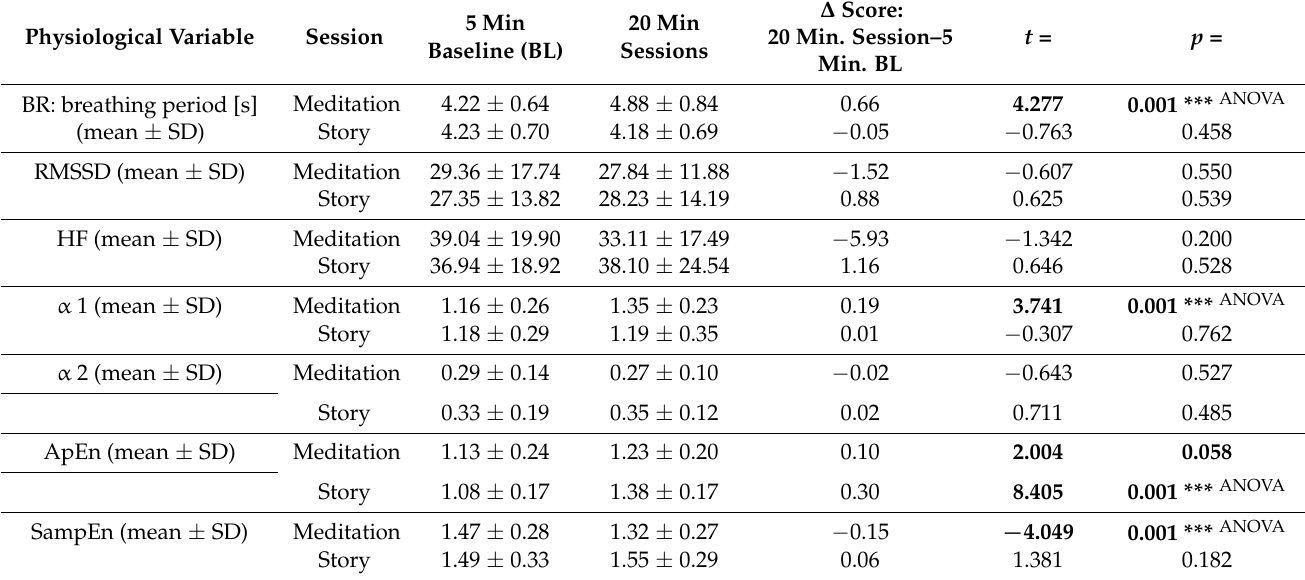
Table 3. Descriptive statistics for the physiological variables for the 5 min baseline (BL) measure and for the two 20 minute meditation and story sessions. A difference score ( ∆ ) indicates the value differences between the 5 min baseline (BL) and the 20 minute experimental session for the respective meditation and story conditions. Significant t -test coefficients for the differences between the two conditions: *** p < 0.001 are marked in bold ; all are significant after FDR correction for 14 tests. ANOVA signifies a significant interaction effect in the repeated-measures